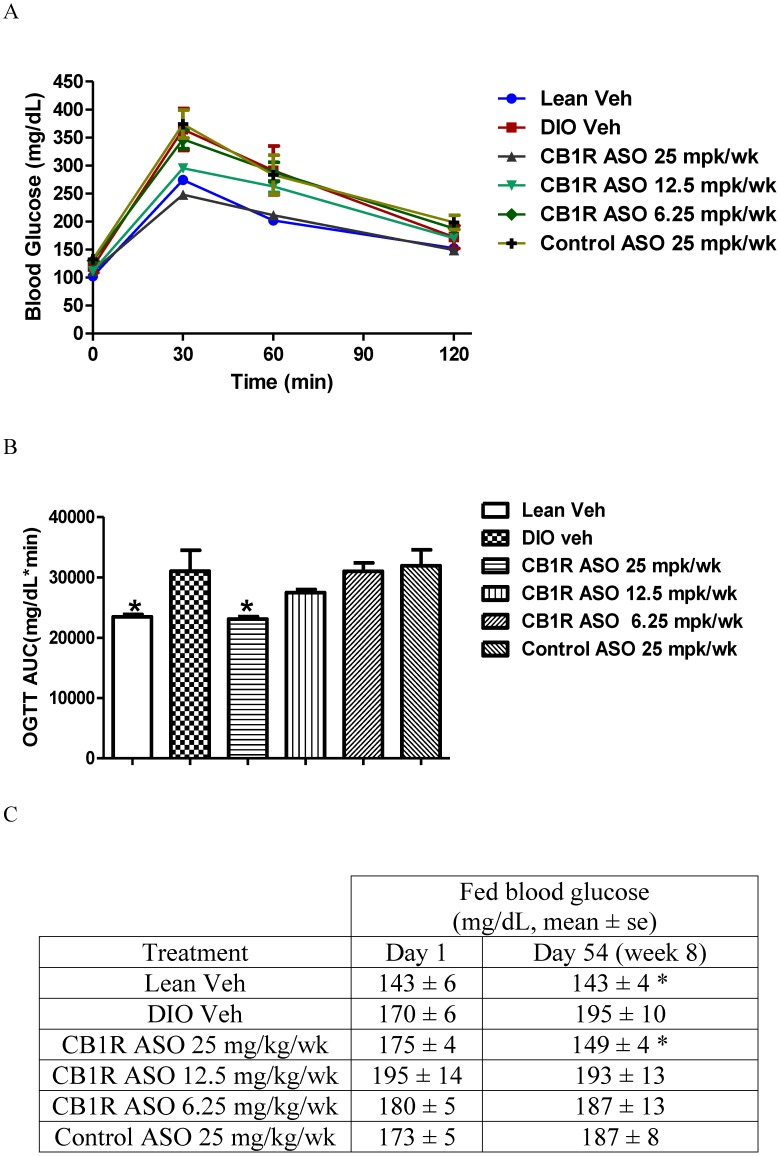
Oral glucose tolerance test (A and B).On Day 64, overnight fasted mice were challenged with oral glucose dosing at 2 g/kg. Blood glucose was measured at 0, 30, 60 and 120 minute after glucose dosing. Glucose area under curve was also calculated. C. Fed blood glucose was measured on day 1 and day 54. Student t-test vs the vehicle group, *, P<0.05.